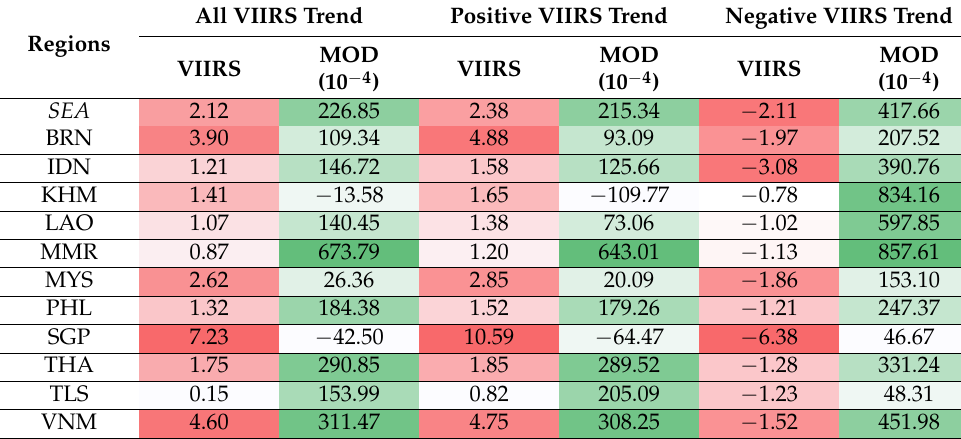
Table 3. The average VIIRS/DNB and MODIS/NDVI trend value under the all VIIRS overall trends, positive VIIRS overall trends (>0), and negative VIIRS overall trends (<0) for only VIIRS change areas (grids count: ≈ 1.85 × 10 6 ). The cell background color shows the different levels of trend values, where a darker color indicates a larger absolute